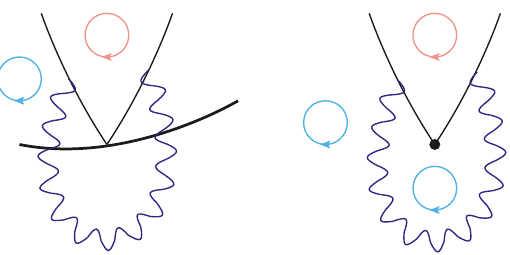
Figure 3. Cartoon of the di(cid:11)erent behaviour in color space between the insertion of an operator on a Wilson line and the color trace of an operator such as in (3.1). In the example the former is not color leading, whereas the latter is. Color loops of the two di(cid:11)erent gauge groups are indicated in blue and red. For instance, the diagram on the left gives rise to a N 1 subleading contribution (and indeed it is graphically non-planar), whereas the graph on the right is leading in N 1